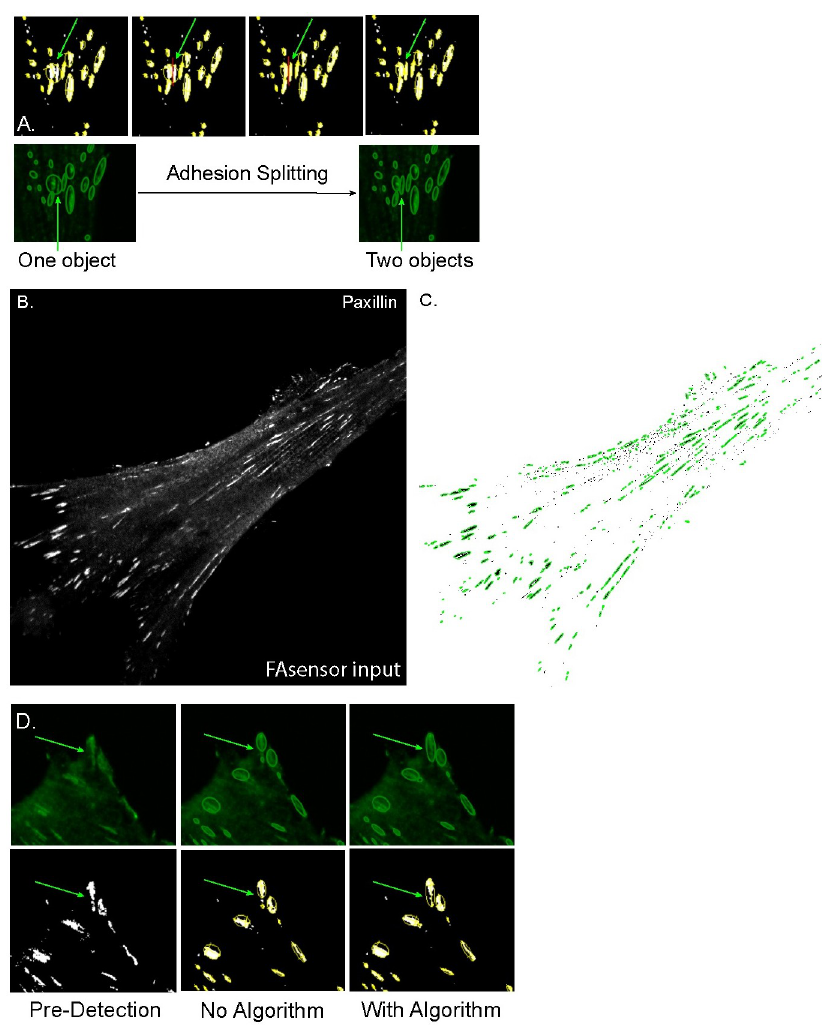
Fig 4. Segmentation of FAs by FASensor and subsequent optimization. A) Montage of adhesion splitting capacity of the FASensor module. (Top) Thresholded image of adhesions (white) have objects detected by module (circled by yellow). Red line is drawn by user to split objects where desired. (Bottom) Before and after images of objects detected in the IF adhesion input, that are split. Green arrow indicates splitting objects in Top and Bottom. B) Input image of focal adhesions (paxillin) in the ventral plane of an MRC5 cell. C) Corresponding segmented adhesion objects (outlined in green) from FASensor. D) Montage showing the closing and filling holes function of the module. (Top series) Objects circled by green detected by FASensor from IF adhesion input. (Bottom series) Objects circled by yellow on thresholded image. (Left) Pre-detection by module (Center) Objects detected when closing and filling holes algorithms are not applied. (Right) Objects detected when closing and filling holes algorithms are applied. Green arrow in the Top and Bottom series indicates the adhesion which is detected as multiple objects without the algorithm and detected as a single object with the